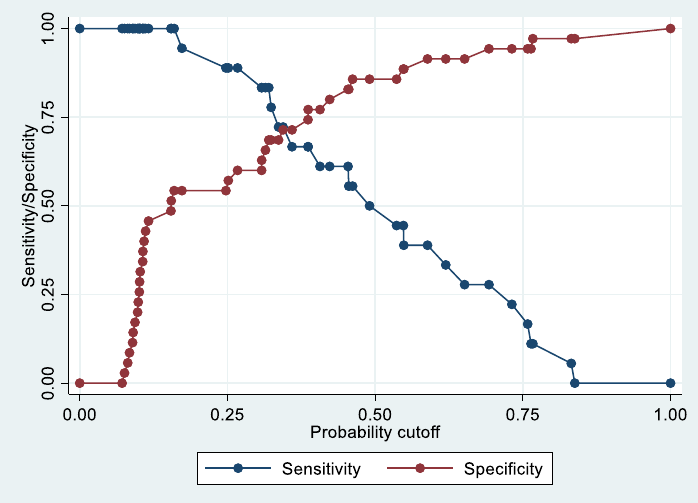
Figure 8. Sensitivity and specificity plot of the final model with the outcome Advanced Stage EC patients vs. controls.